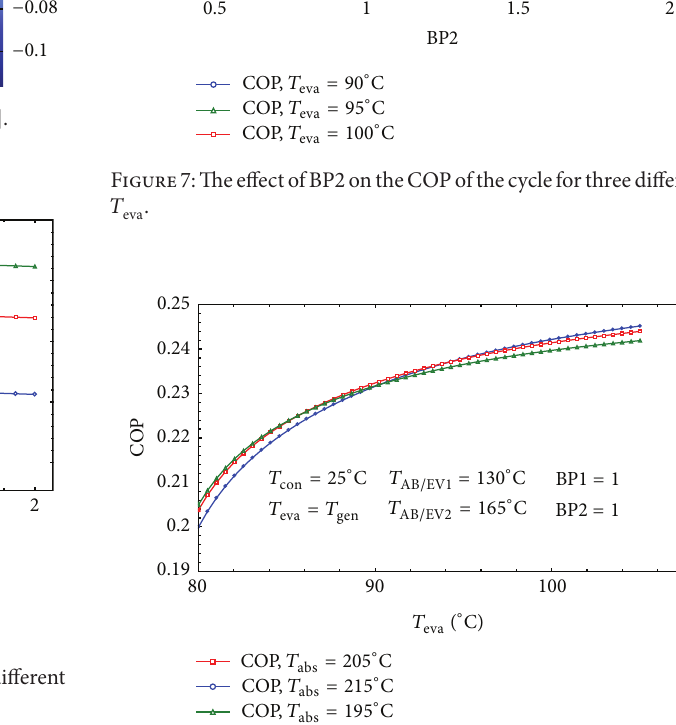
ontheCOPofthecycleforthreedifferent eva